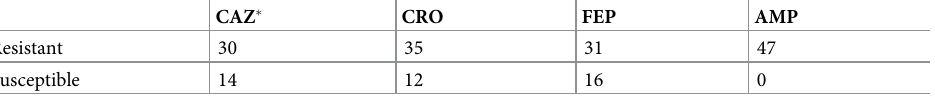
Table 3. Susceptibility to ceftazidime (CAZ), ceftriaxone (CRO), cefepime (FEP) and ampicillin (AMP). Clinical susceptibility classifications of isolates in the presence of four antibacterial agents. � Three intermediate samples excluded.